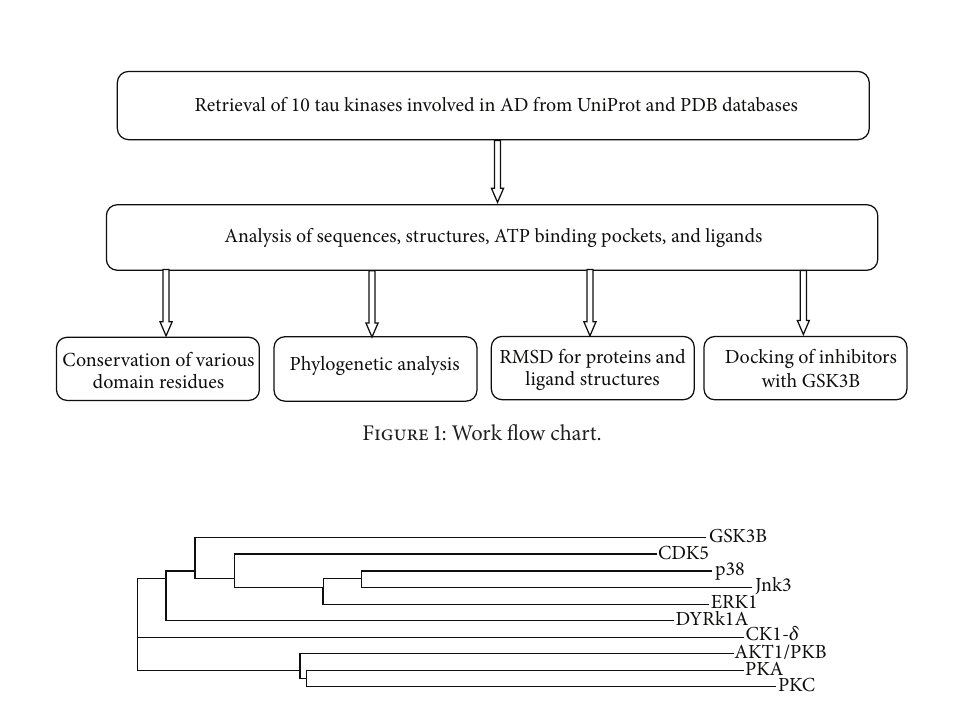
Figure 2: Phylogenetic tree generated for sequences of the tau kinases using CLUSTALW